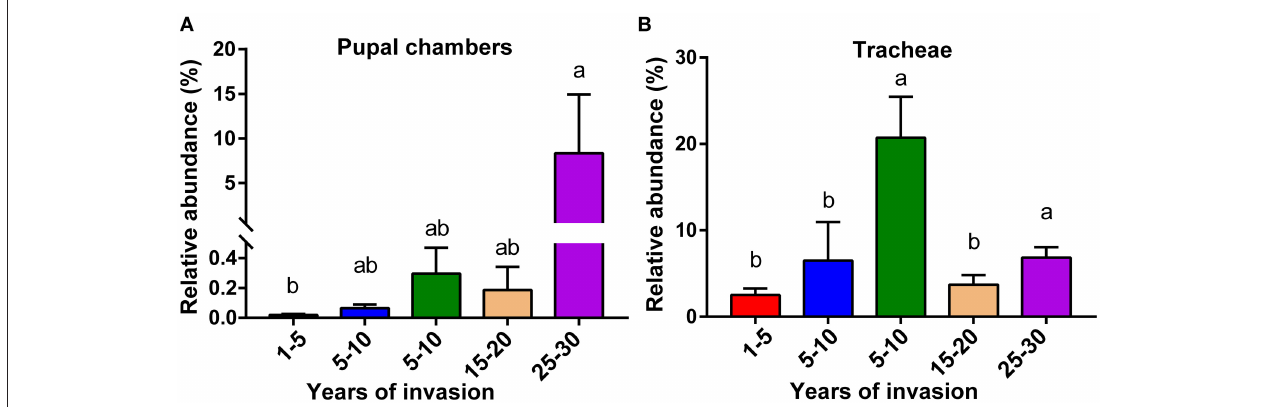
FIGURE 4 | The relative abundance of genus Serratia involved in pupal chambers (A) and tracheae (B) from sites differing in the duration of PWN invasion (years of invasion in the X-axis). Data are presented as means ± SEM, Kruskal-Wallis H -test, p < 0.05. Different letters indicate statistically significant differences.